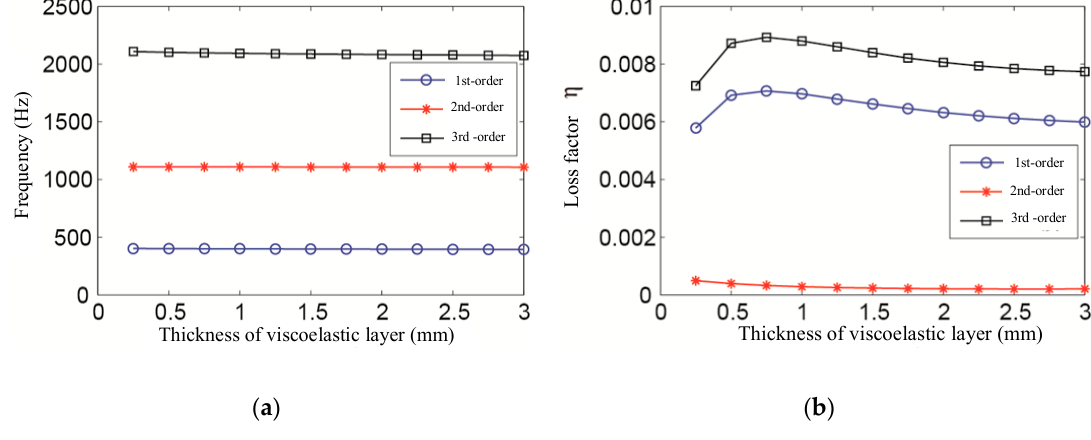
Figure 15. Influence of thickness of viscoelastic layer on the ( a ) modal frequency and ( b ) loss factor.